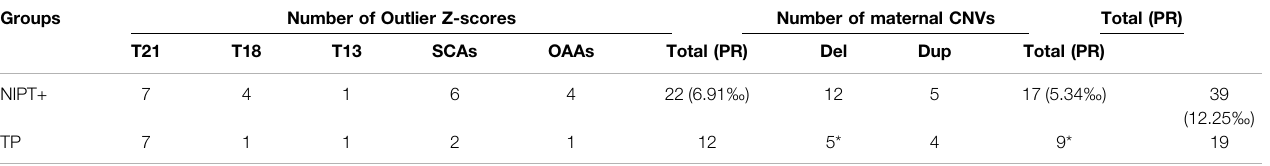
TABLE 1 | Results from the Cohort of 3184 Pregnancies with NIPT Combining Z-score and Maternal CNV.